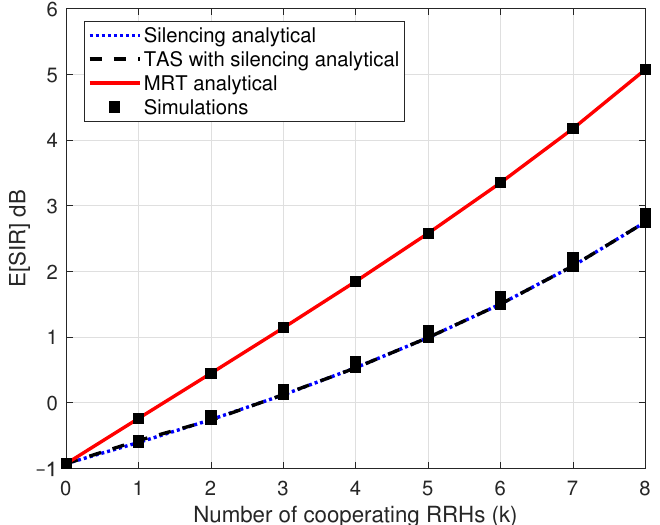
Figure 3. Expected value of SIR for silencing, TAS with silencing and MRT schemes as a function of number of cooperating RRHs k .